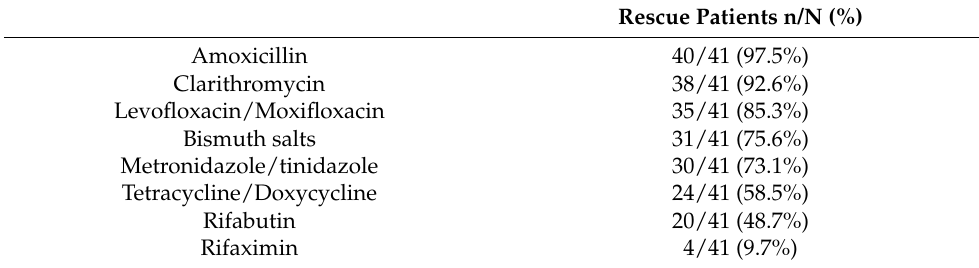
Table 1. Antibiotic usage before HDDT in non-naive